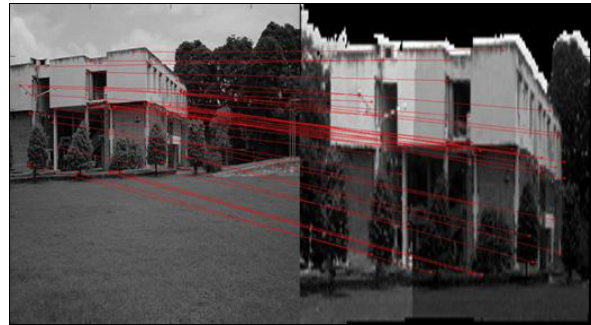
Figure 5. Refined matching results of camera image (left) and LiDAR intensity image (right) after RANSAC